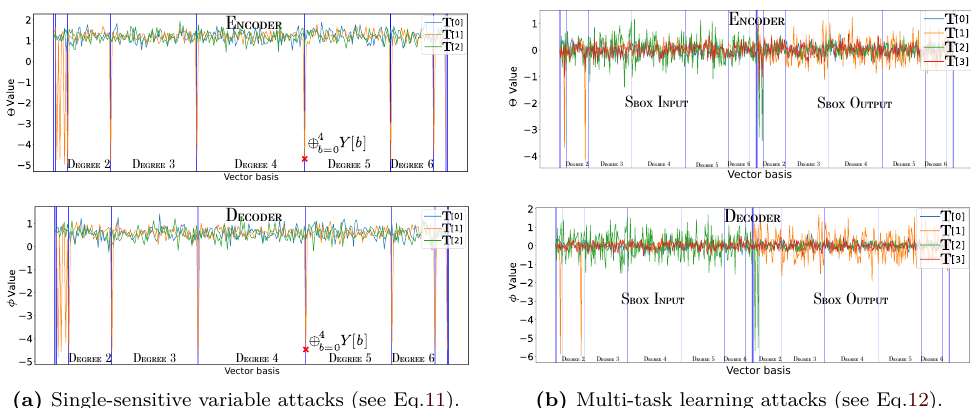
Figure 3: Weight visualization assessing the suitability of our generative model to retrieve the leakage